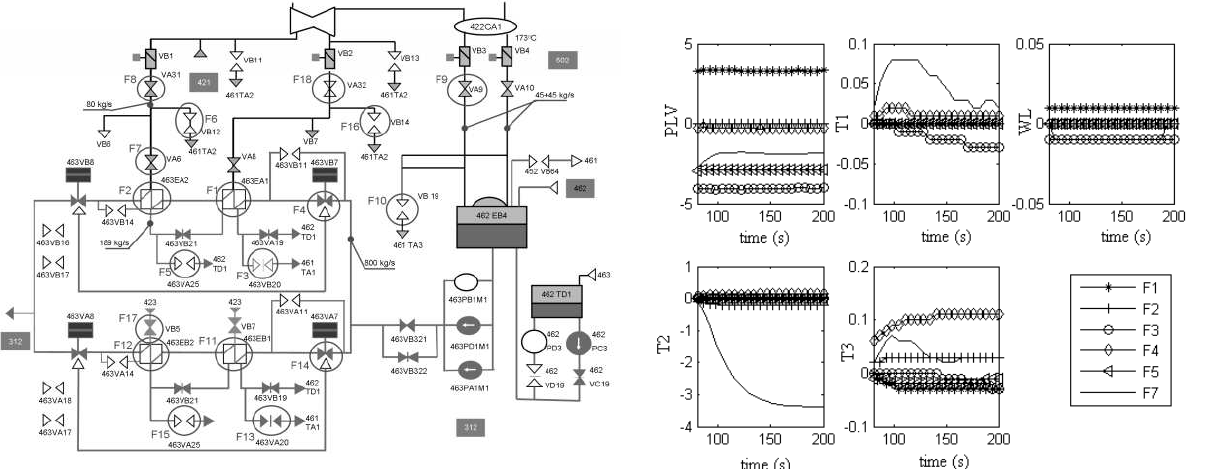
Fig. 11. Sketch of the feedwater system 33 Fig. 12. Time-evolution of the five monitored variables deviations (in abscissa the time in seconds and in ordinate the variable deviation from steady